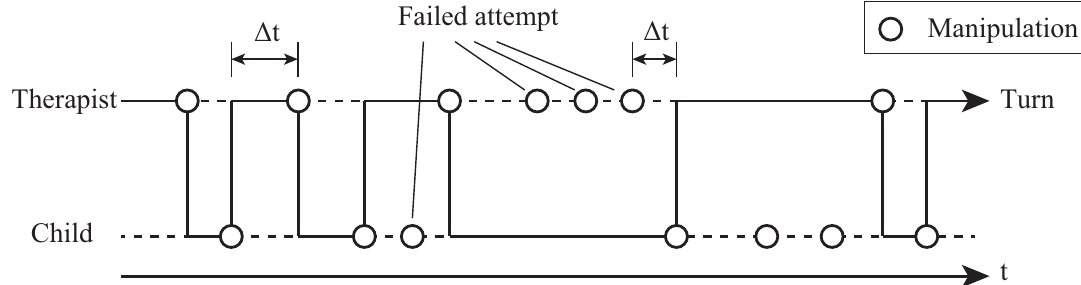
Figure 3. Criteria used to analyze the data from COLOLO. Each mark represents manipulations of the toys made by two users. They are separated in two time lines and used to describe the exchanges made by the child and the therapist during the